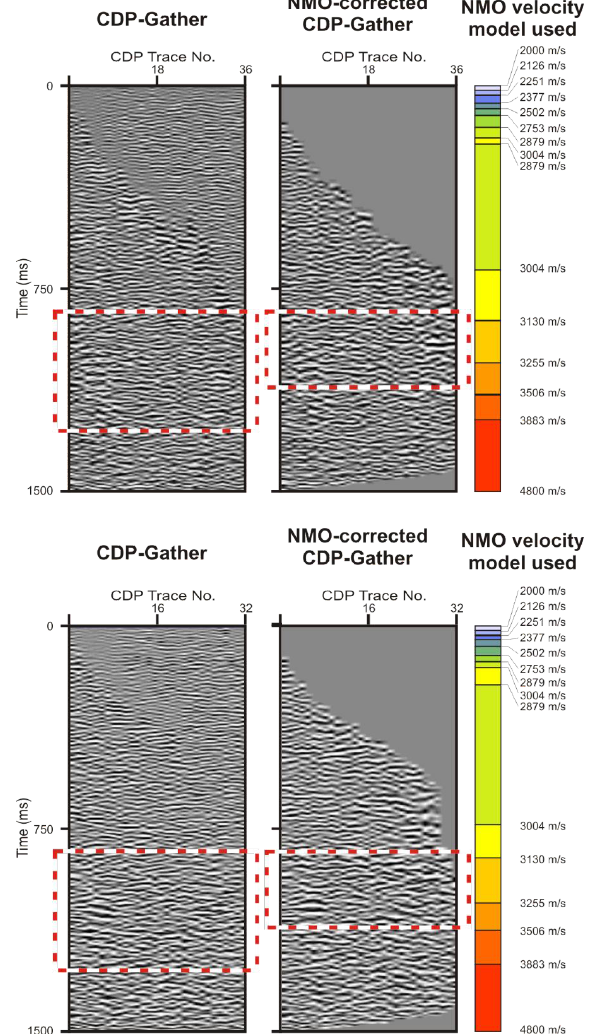
FIG. 9: Example of two CDP-gathers from different areas before and after NMO- Fig. 9. Example of two CDP gathers from different areas before and after NMO correction, and the two NMO velocity models applied correction, and the two NMO velocity models applied in each case. The highlighted in each case. The highlighted boxes mark a reflectivity area whose boxes mark a reflectivity area whose reflections are not continuous even after a correct reflections are not continuous even after a correct NMO NMO correction.